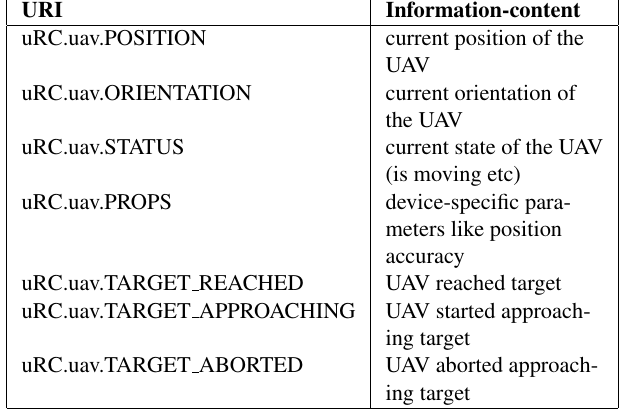
Table 2: Topics UAVs publish information on